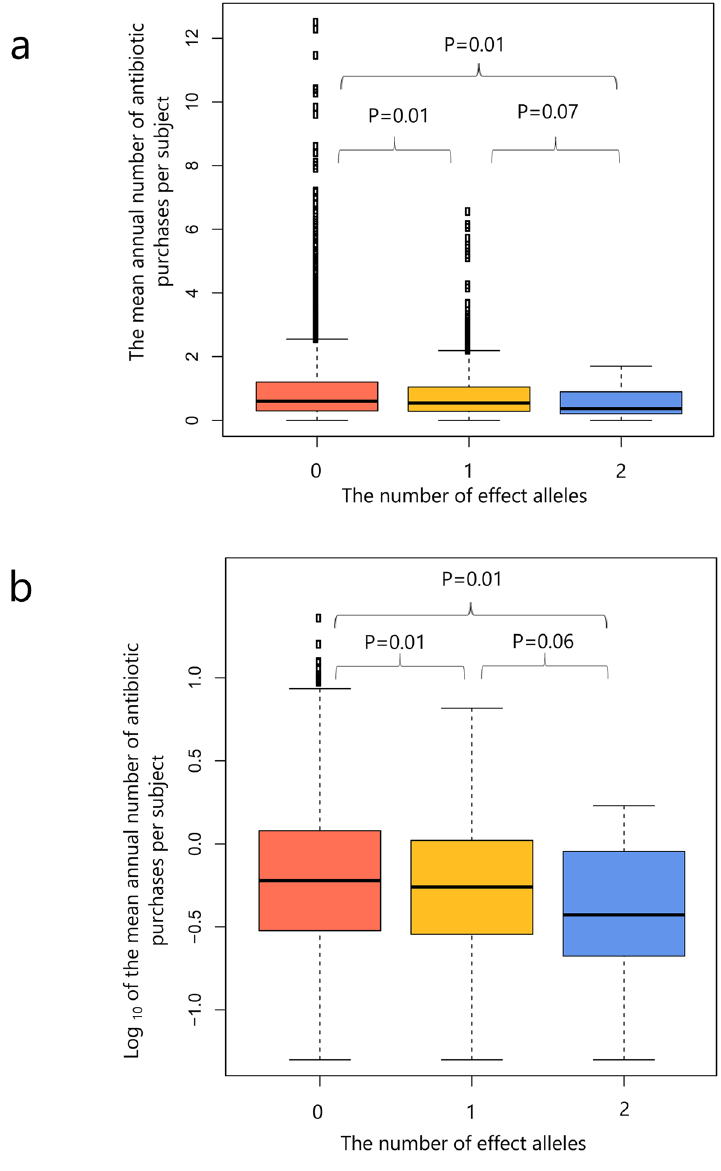
Figure 3. Boxplots demonstrating the median and interquartile range of ( a ) the mean annual number of antibiotic purchases per subject, and ( b ) the logarithmically transformed mean annual number of antibiotic purchases per subject, in individuals with 0 effect alleles (N = 4231), 1 effect allele (N = 817), and 2 effect alleles (N = 44) of rs62192851. Only individuals from the FinnDiane study were included. Differences between groups were investigated with the Mann–Whitney U